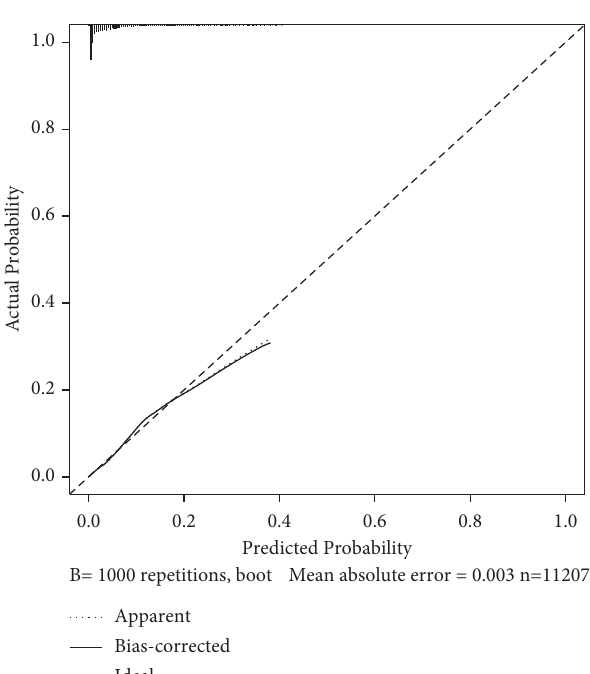
Figure 3: Te calibration curves of the nomogram for the risk of mortality. (Te x -axis represents the nomogram-predicted probability, and the y -axis represents the actual probability. A perfect prediction would correspond to the 45 ° black dashed line. Te black dotted line represents the entire cohort ( n � 11,207), and the black solid line is bias-corrected by bootstrapping ( B � 1000 repetitions), indicating observed nomogram performance.